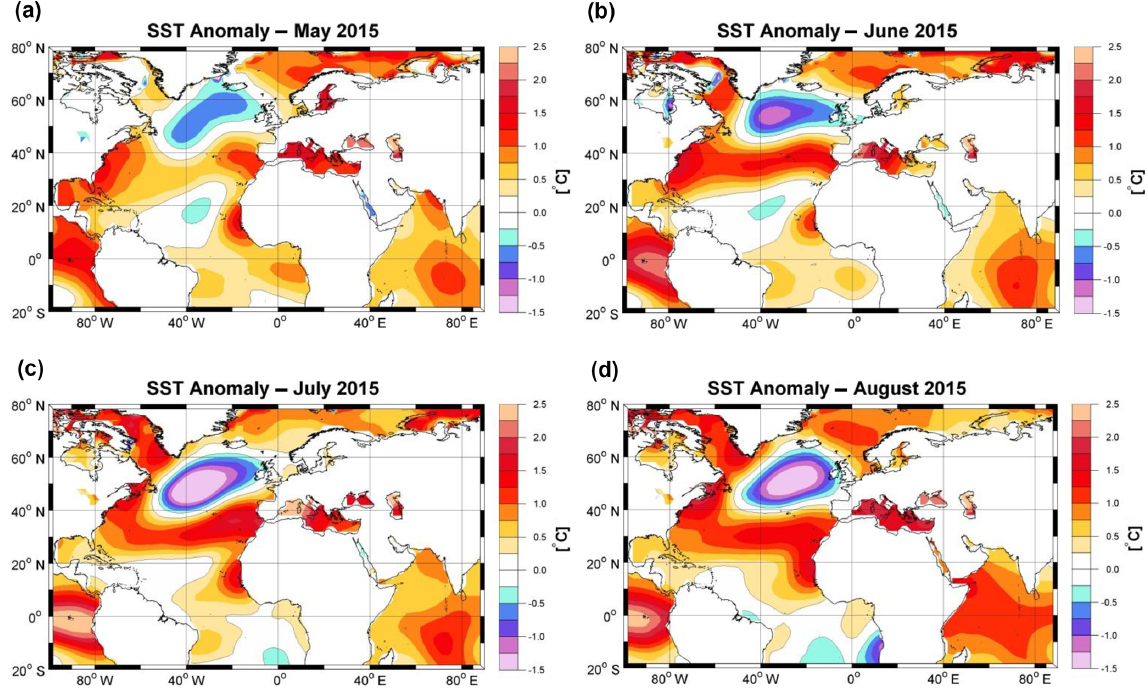
Figure 4. Monthly SST anomalies: (a) May 2015; (b) June 2015; (c) July 2015 and (d) August 2015. The anomalies are computed relative to the period